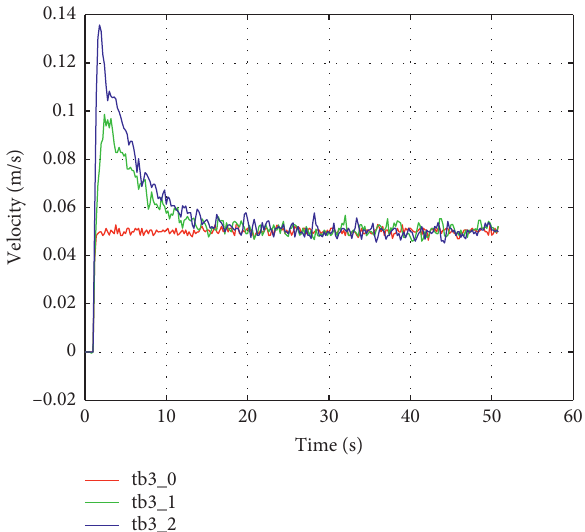
Figure 10: Velocities of TurtleBot3 mobile robots in the experiment.